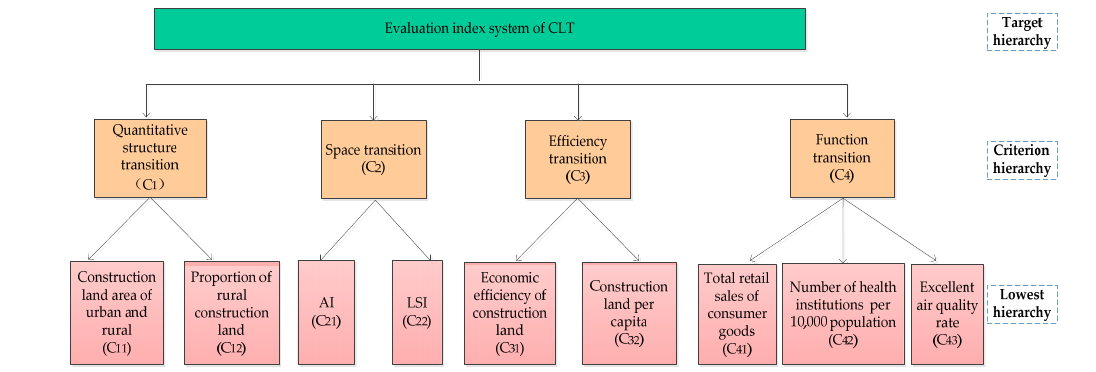
Figure 5. Evaluation index system of CLT. Table 1. Weight value of the evaluation index for RT and